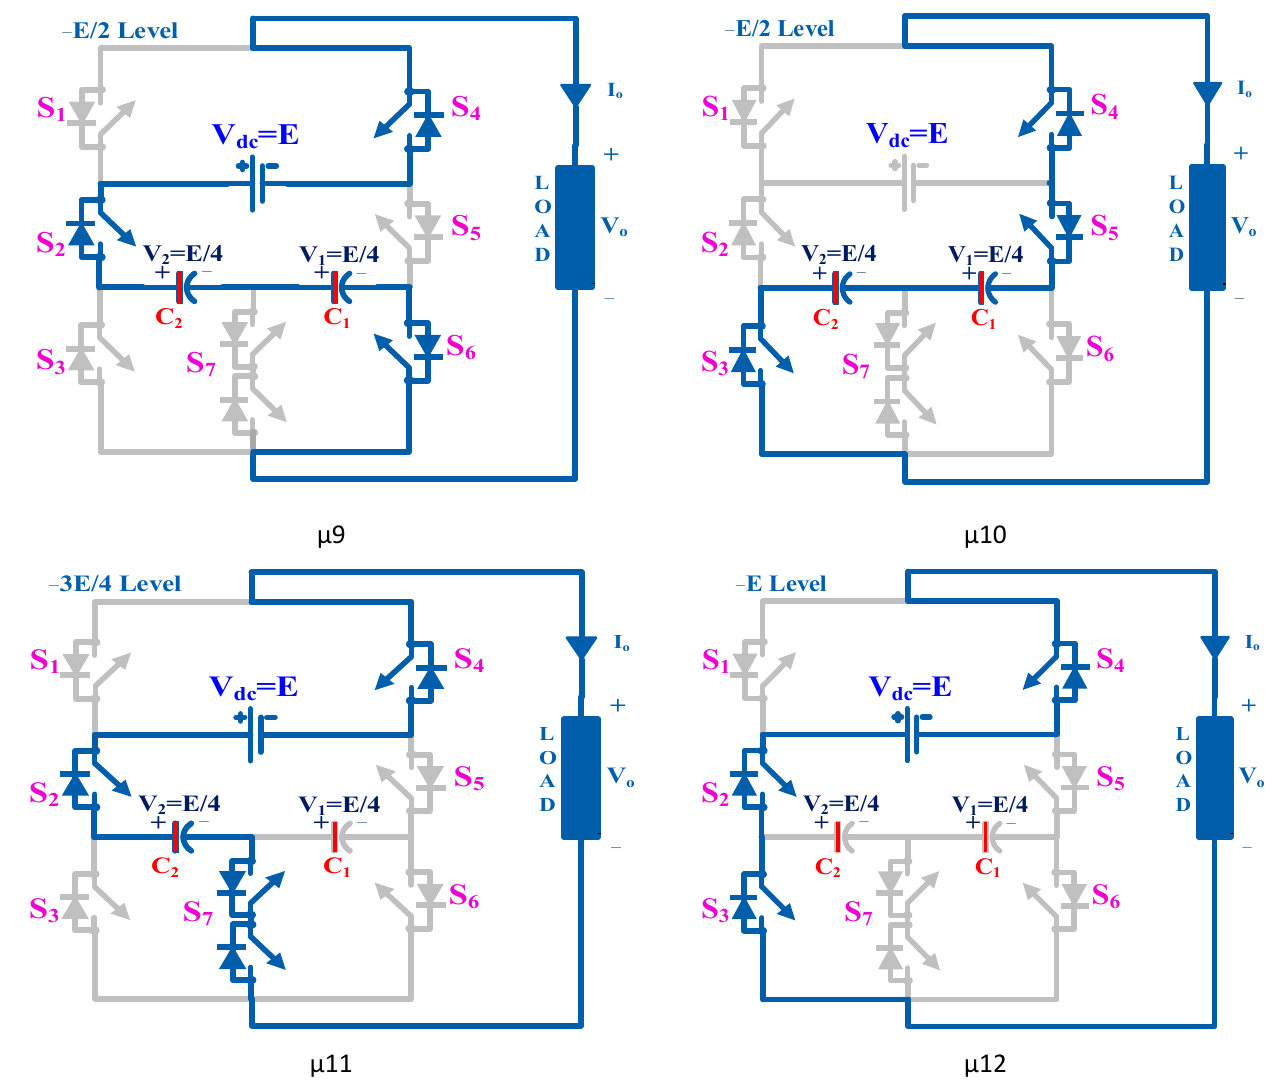
Figure 3. Conduction paths of existing 9-level PEC9 topology.